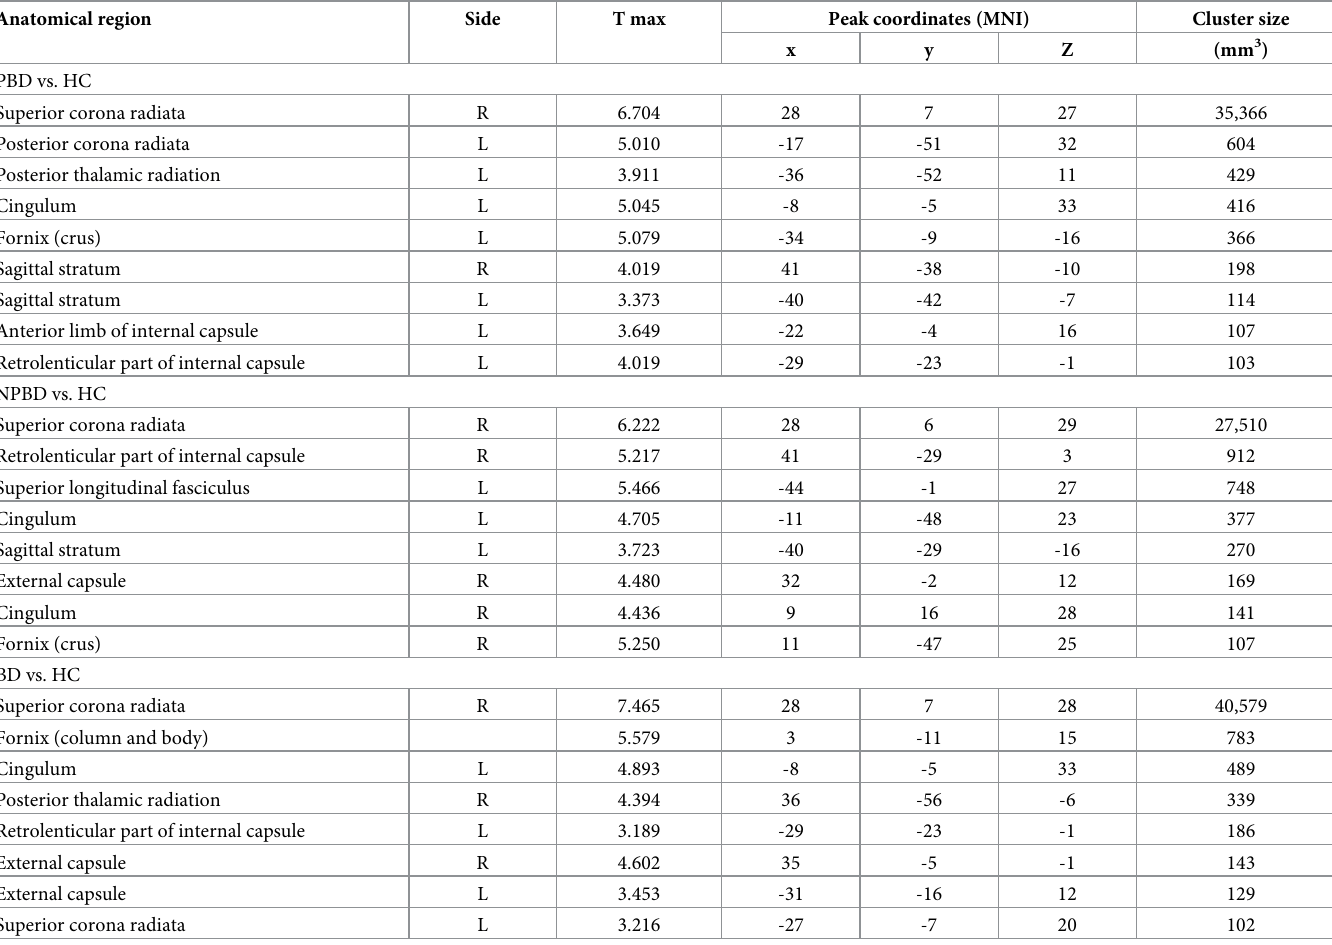
Table 3. Comparisons of mean diffusivity among PBD (N = 29), NPBD (N = 23), BD (PBD + NPBD) (N = 52), and HC (N = 65) groups a